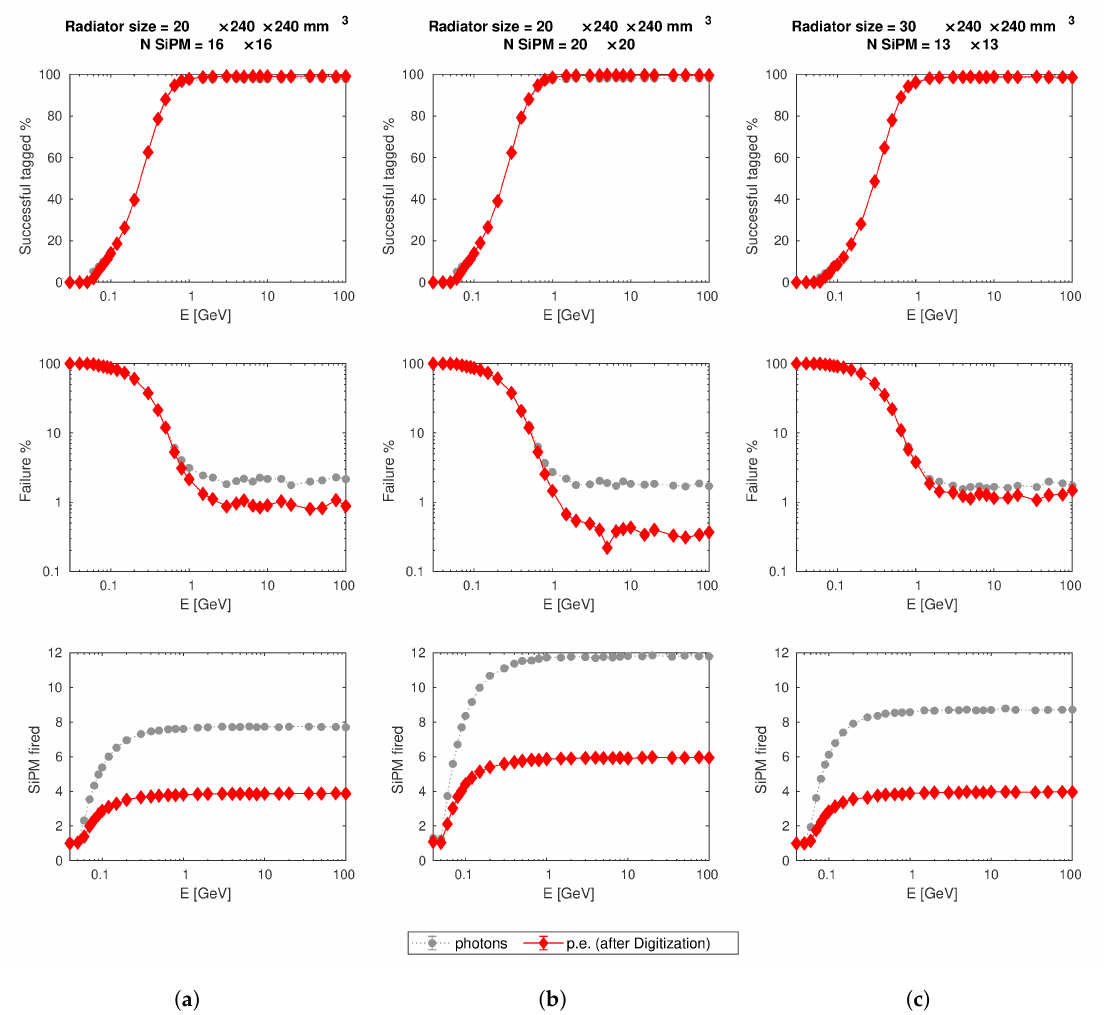
Figure 3. Results of Geant4 simulation as a function of the kinetic energy E of the primary particles (muons). Each column of subplot ( a – c ) refers to a different simulation scenario, in which radiator size and/or number of SiPM have changed, as shown in the title. The mean number of SiPM fired at each energy was calculated on successful reconstructed events only. The vertical error bars (equal to ± 1 σ ) are drawn, but not visible due to the small